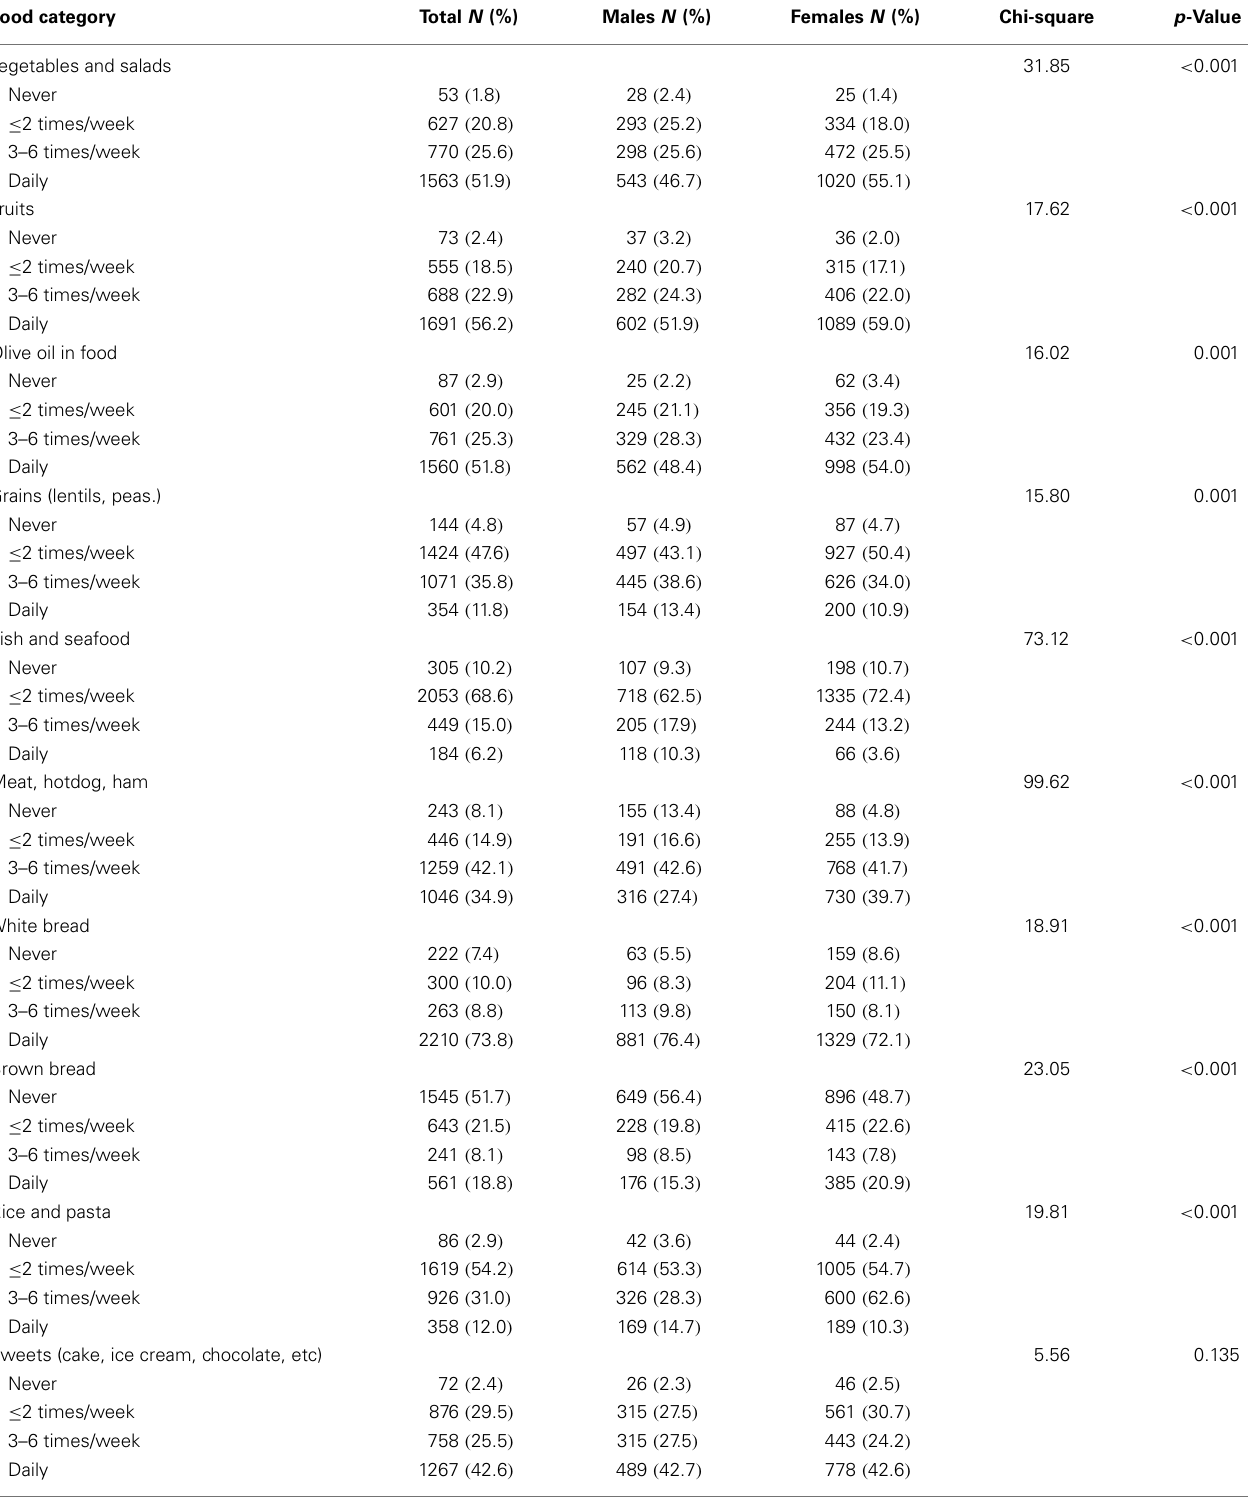
Table 2 | Dietary intake of university students as assessed by a food frequency questionnaire, in total study sample and by gender